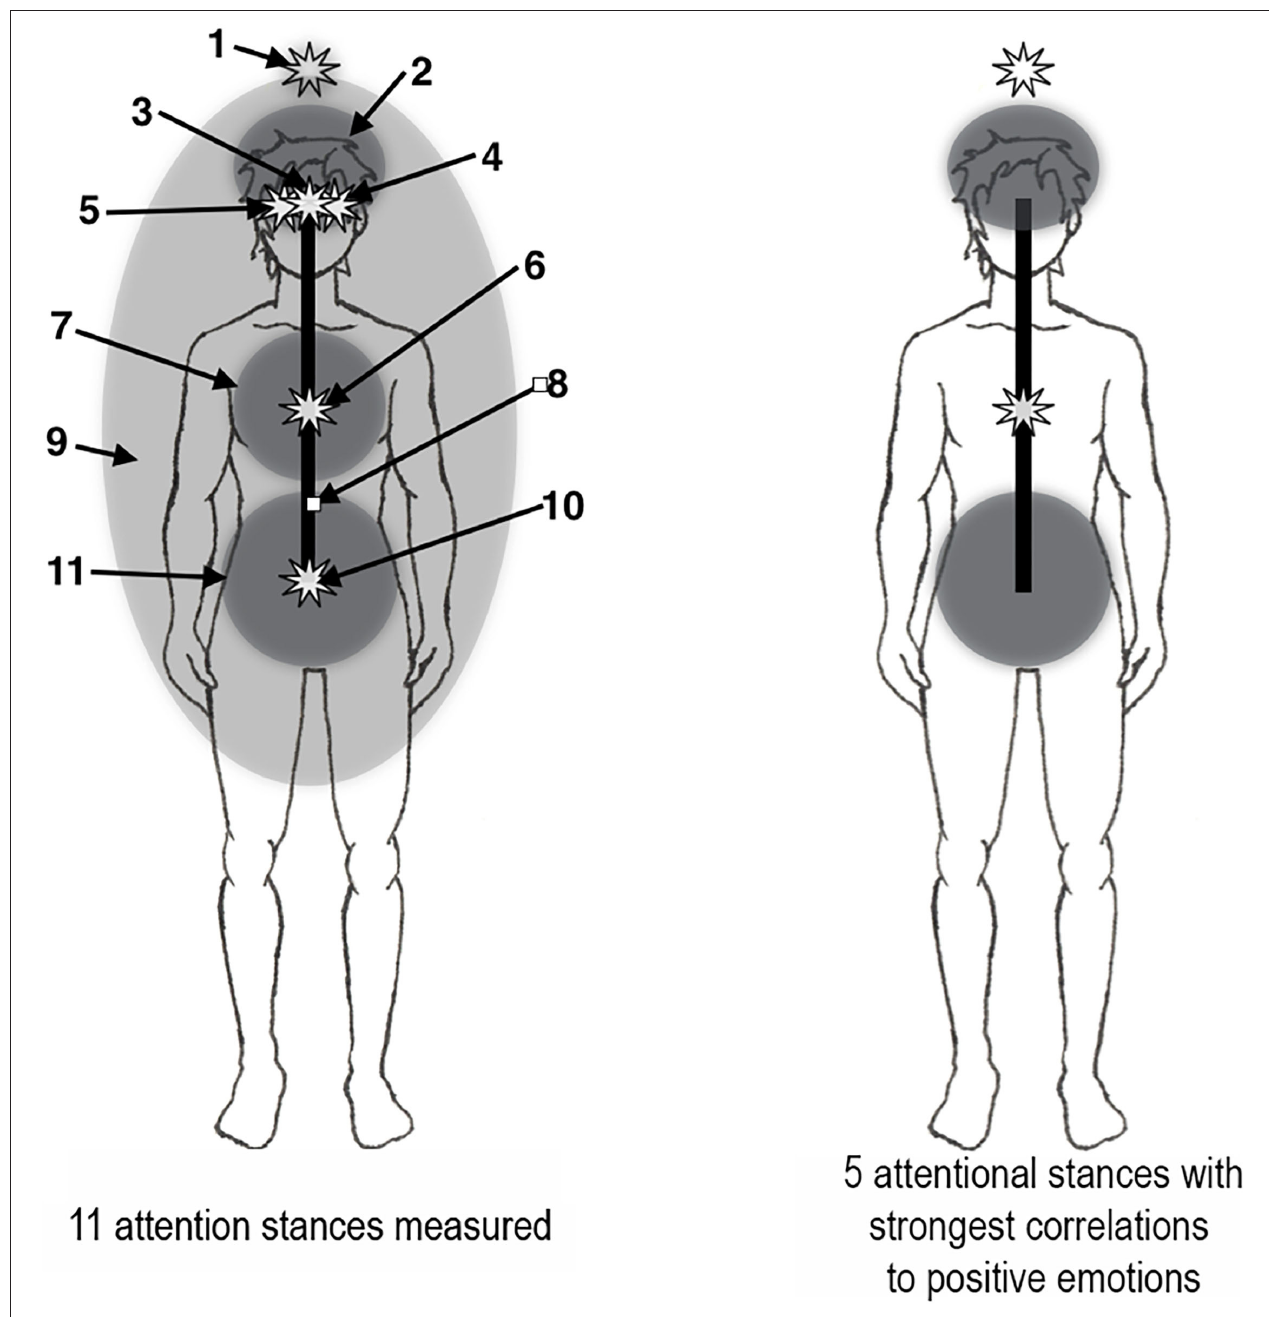
FIGURE 1 | Seat of attention situated in attentional stances. Left: The 11 attentional stances measured (see text). Right: The 5 attentional stances with strongest correlations to positive emotions (see Table 1 ).